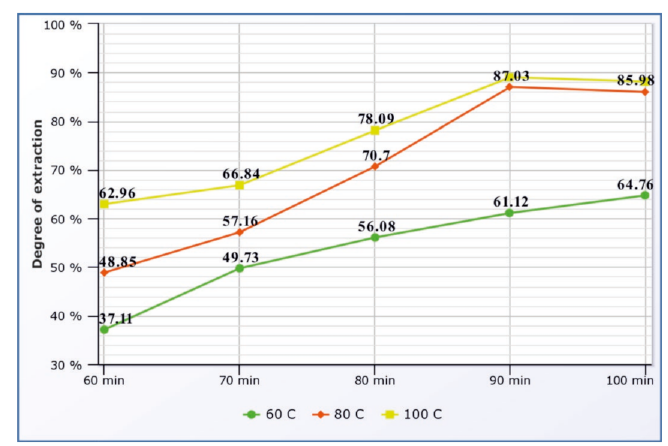
Figure 5. Influence of temperature and time on the degree of extraction.